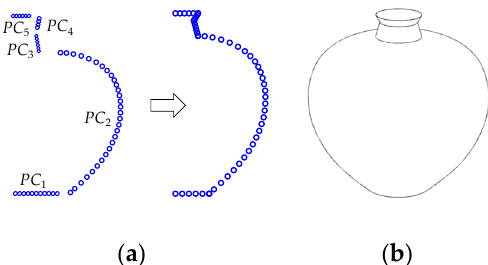
Figure 17. Solid CAD modeling of the ewer body. ( a ) Basic point cloud of the body; ( b ) solid CAD model constructed using the basic point cloud.